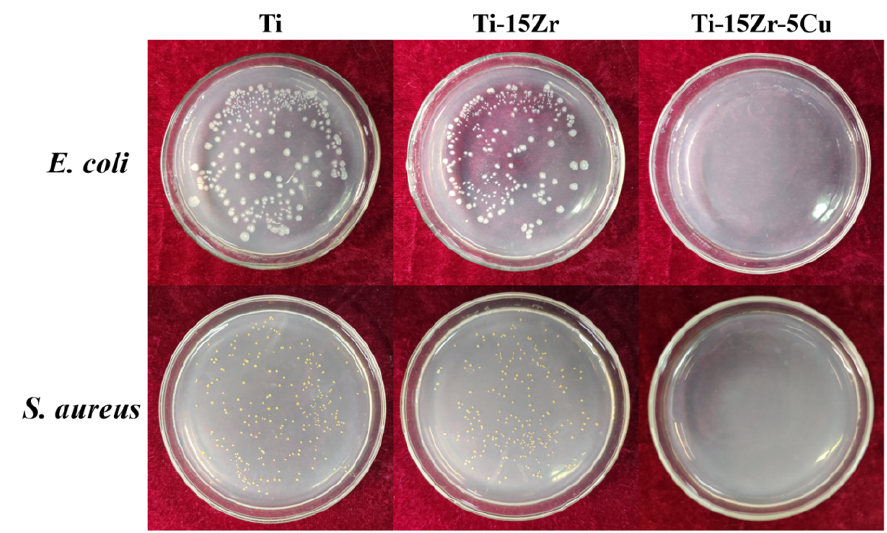
Figure 7. Antibacterial test results of the commercial pure Ti, the Ti15Zr alloy and the ultrafine- grained Ti15Zr5Cu alloy co-cultured with E. coli and S. aureus for 24 h.